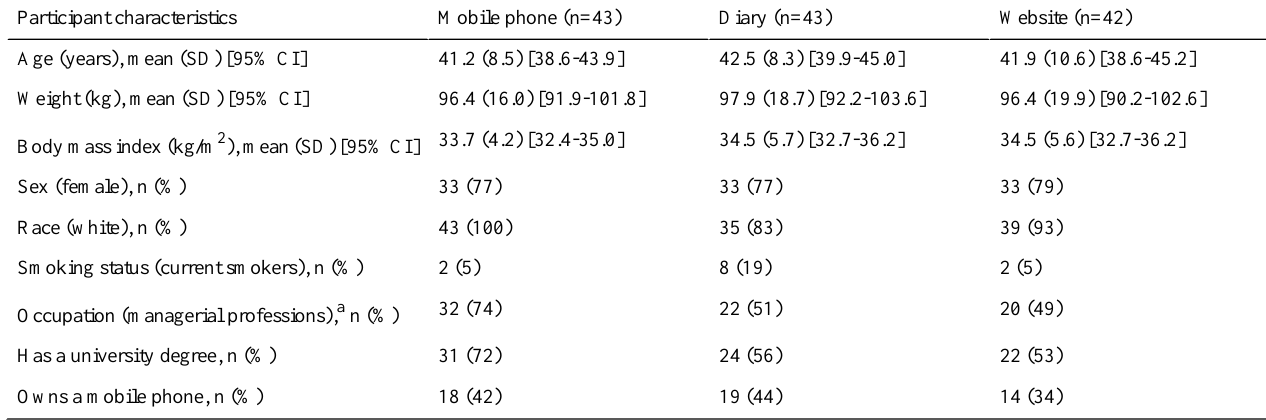
Table 1. Baseline characteristics of all participants enrolled in the My Meal Mate pilot